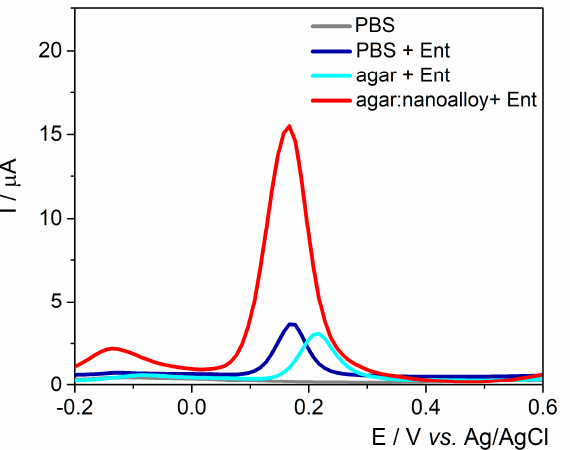
Figure 2. DPV for PBS pH 7.4 and 25 μ M Ent on unmodified graphite SPE and modified with the agar hydrogel with/without the Au/Ag nanoalloy.